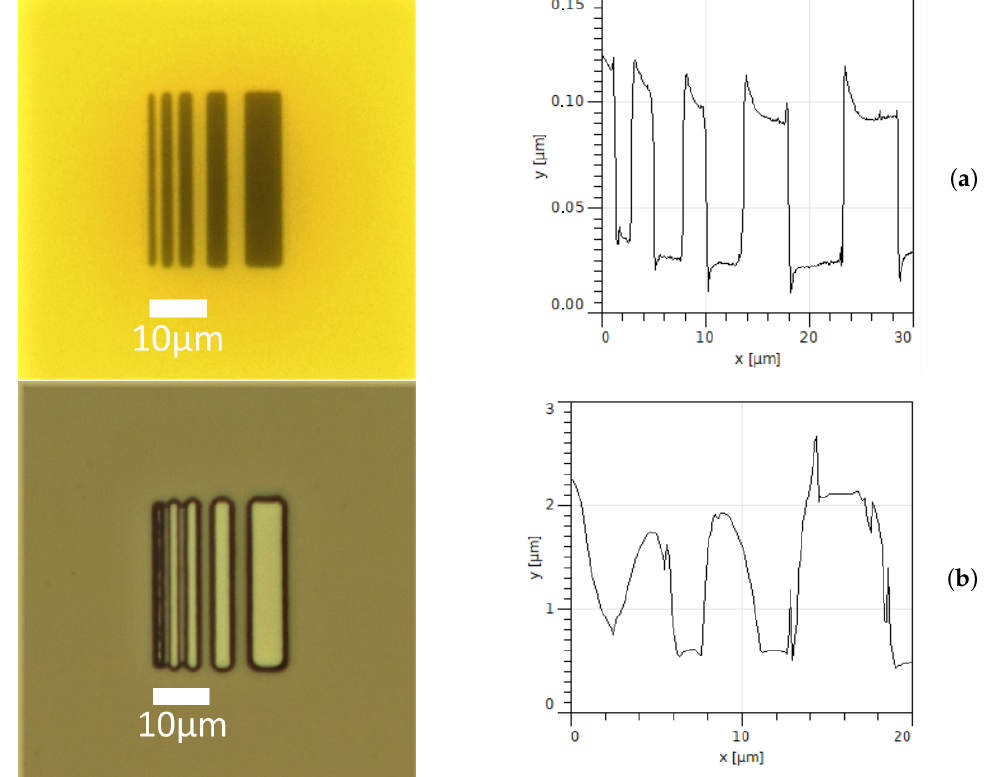
Figure 4. Photo and AFM scan of ( a ) the mask and ( b ) the patterned resist. The narrowest line width and distance between the lines in the mask equal to 1.5 µ